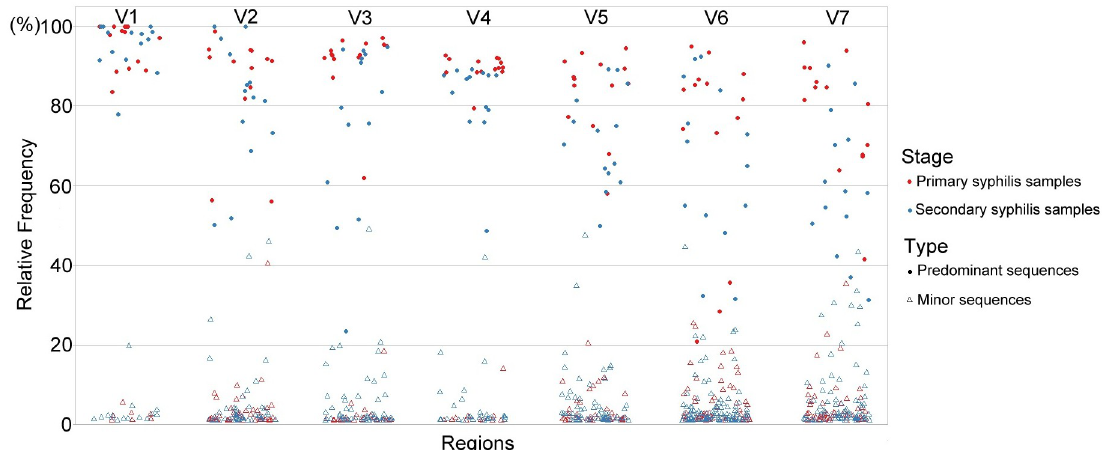
Fig 2. Proportional distribution of the captured distinct nucleotide sequences within each V region of tprK from each strain. Each circle presents the relative frequency of a distinct sequence within the V region in each strain. The solid and hollow circles indicate the predominant sequences and the minor variants in the populations, respectively. The two colors specify the strains from the samples at the two different